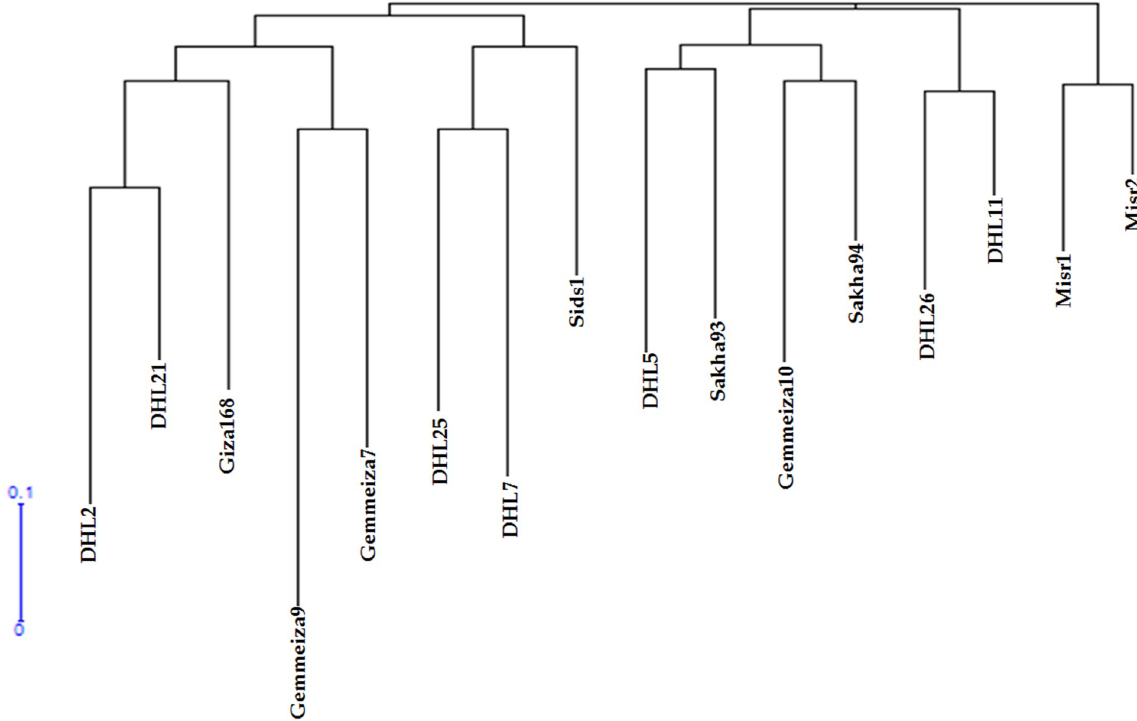
Fig 1. Dendrogram obtained using NJ clustering procedures in 16 wheat genotypes by using SSR data based on Jaccard genetic dissimilarity index. DHL: Doubled haploid line.